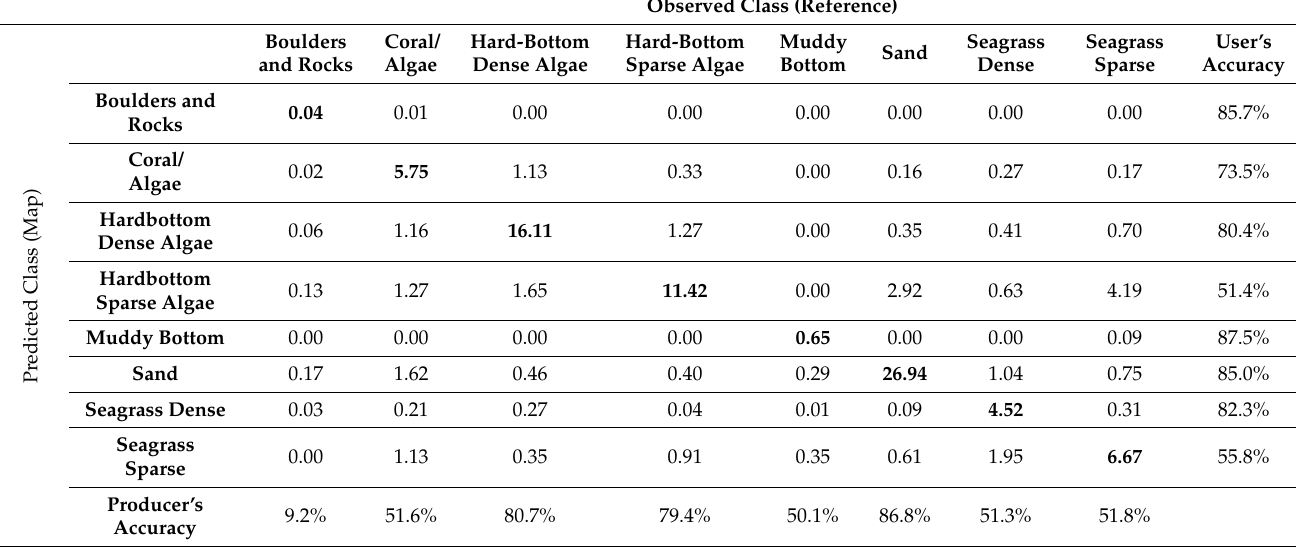
Table 9. Accuracy assessment of the Caribbean benthic habitat product using 2686 field data points collected between 2010–2017 with reef classes combined. The reported overall accuracy is 72% (not shown in the table). The numbers in the diagonal cells (depicted in bold) represent the proportion of total area correctly classified for each benthic class. Classes along the top of the table (columns) represent the observed (reference) data, and the classes on the left side (rows) represent the predicted (map) classes. All numbers reported in each table represent the proportion of the total area.